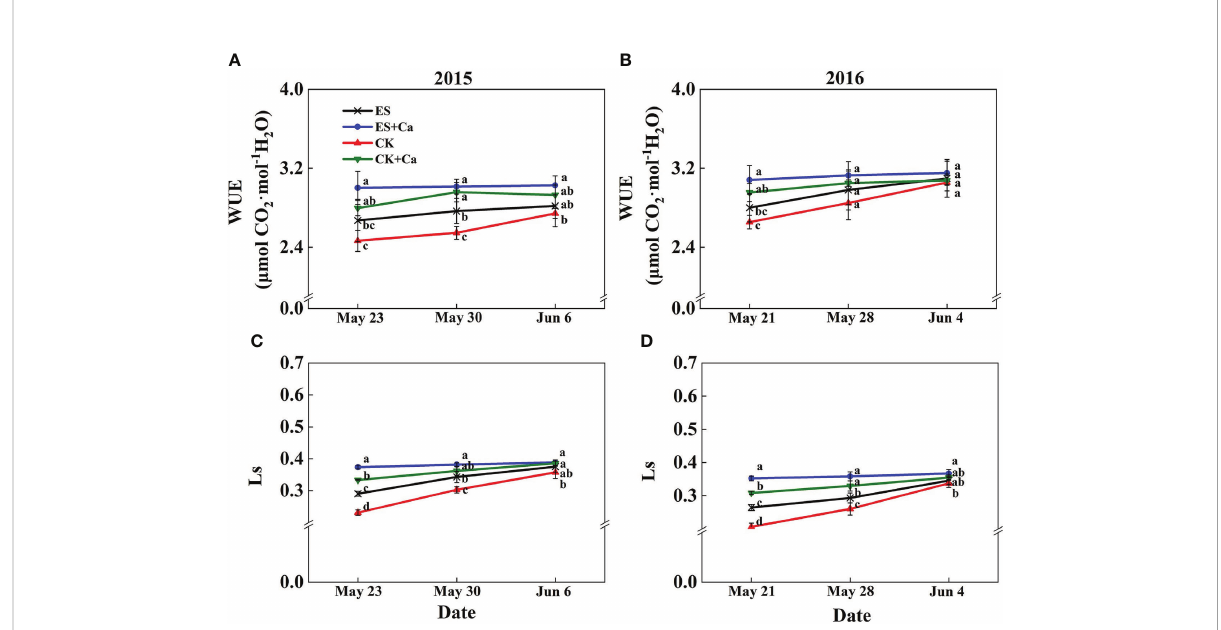
FIGURE 6 Effects of exogenous foliar calcium (Ca 2+ ) application on peanut water-use ef fi ciency (WUE, A , B ) and leaf stomatal limitation (Ls, C , D ) under early and normal sowing scenarios. Values are means ± SD (n = 3). Different letters indicate signi fi cant differences according to Duncan ’ s multiple range tests ( p < 0.05).